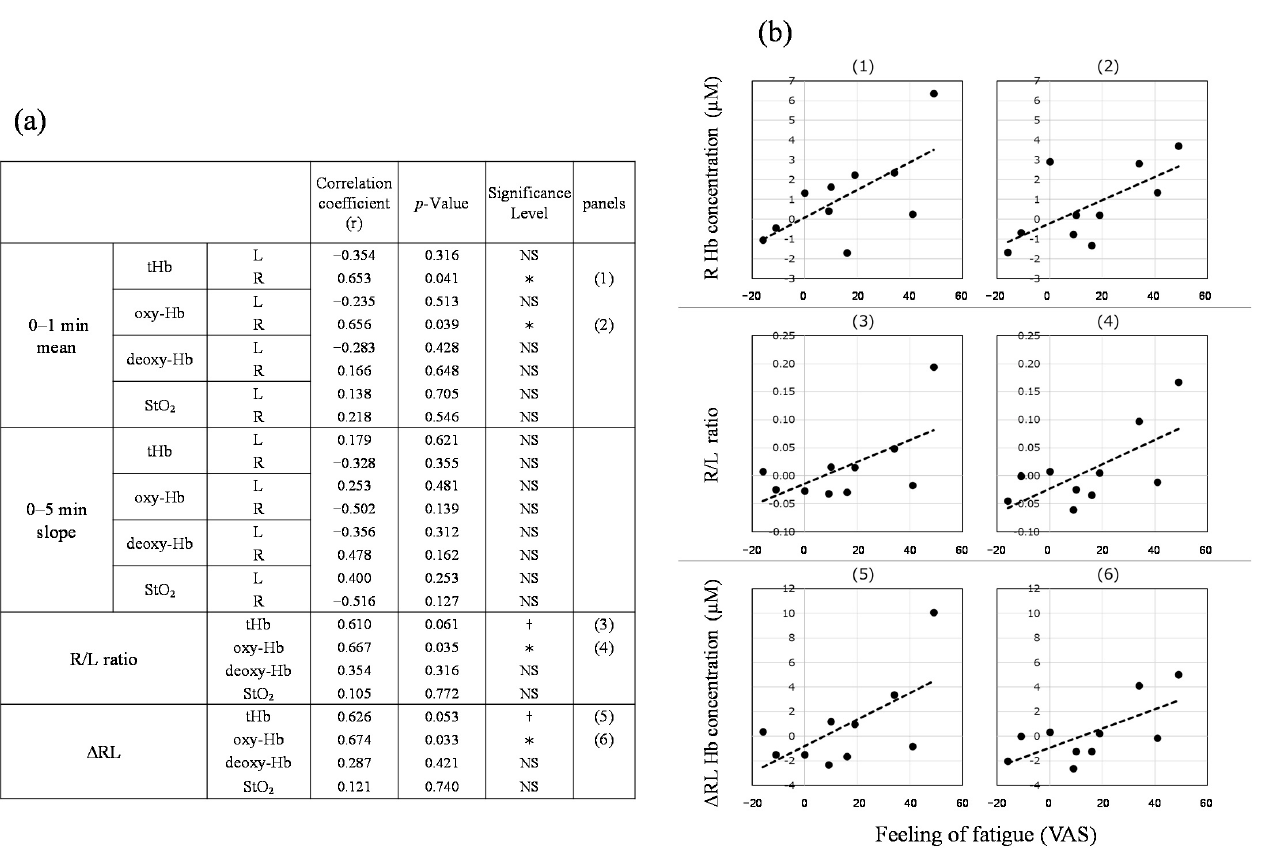
Figure 4. Correlation analysis of the visual analog scale (VAS) of the feeling of fatigue and near- infrared time-resolved spectroscopy (TRS) data. ( a ) Correlation coefficient and ( b ) scatterplot. † p < 0.1; * p < 0.05. NS, not significant; Hb, hemoglobin; oxy-Hb, oxygenated hemoglobin; deoxy-Hb, deoxygenated hemoglobin; tHb, total hemoglobin; StO 2 , tissue oxygen saturation; L, left prefrontal cortex; R, right prefrontal cortex; R/L ratio, right-left ratio; Δ RL, right-left difference.